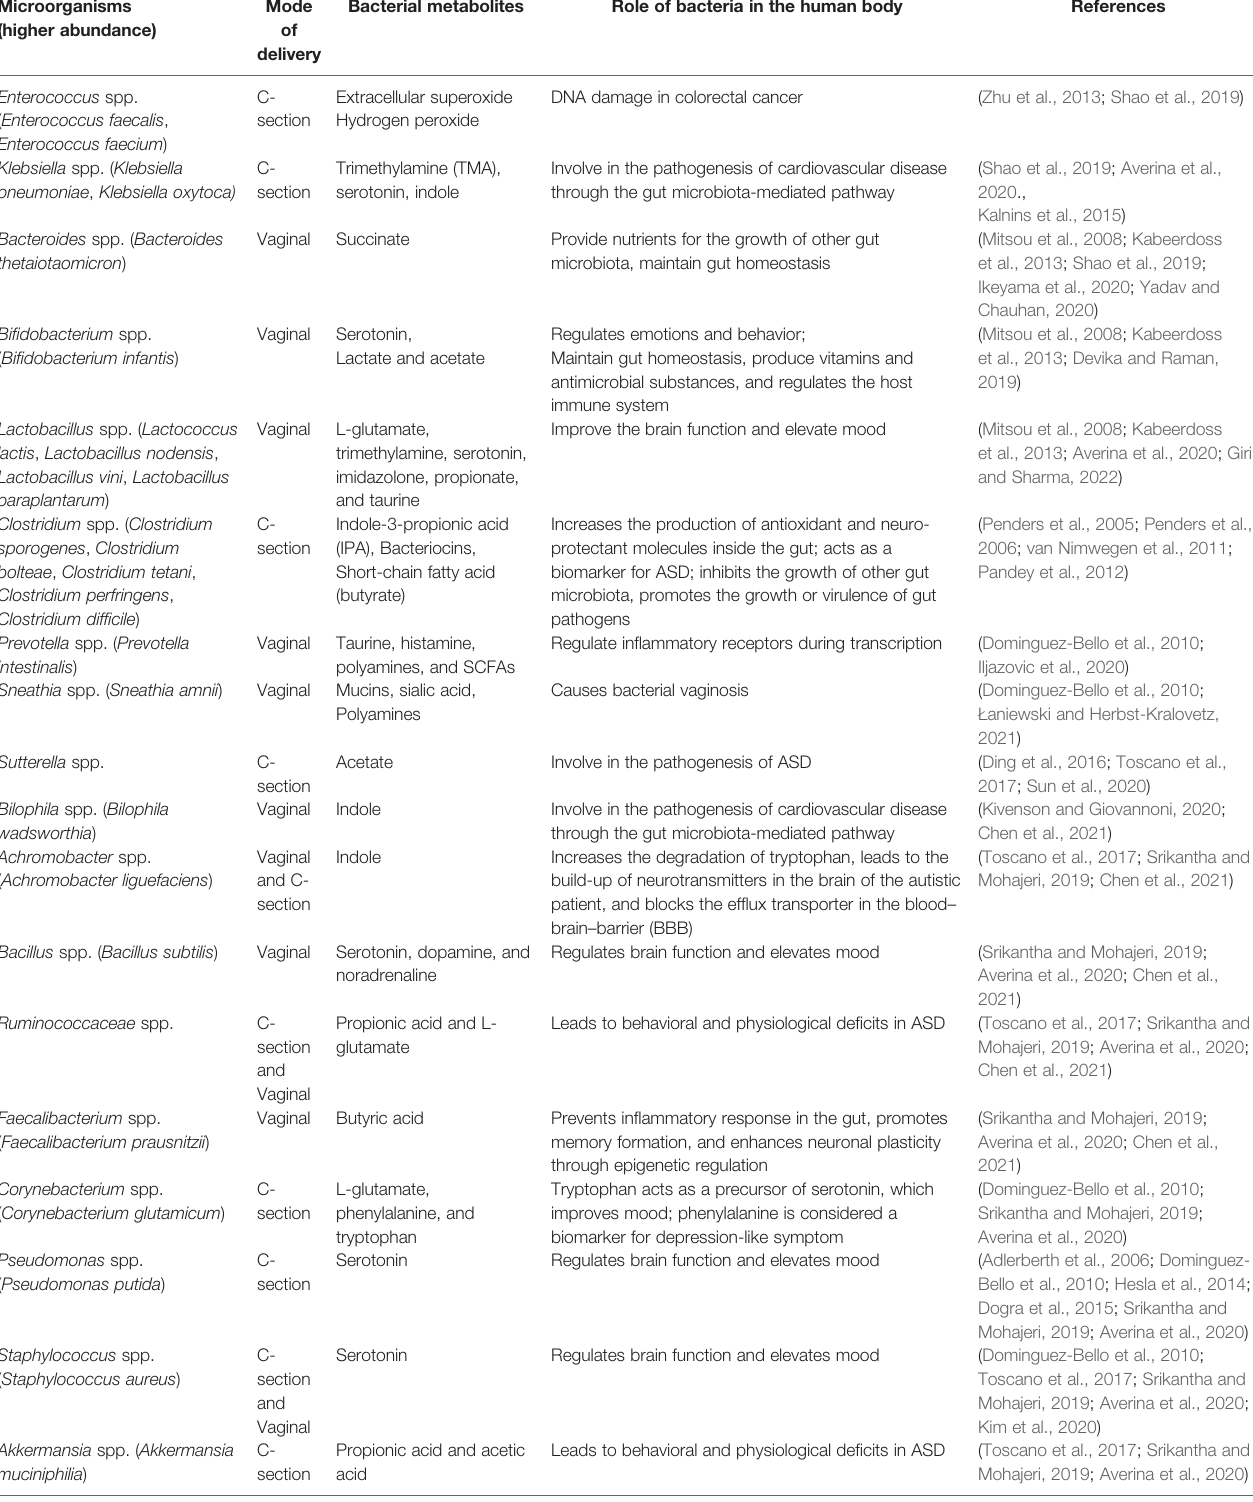
TABLE 1 | Difference in the mode of delivery represents distinctive gut microbiota consortia, which produce metabolites and play essential roles in the human